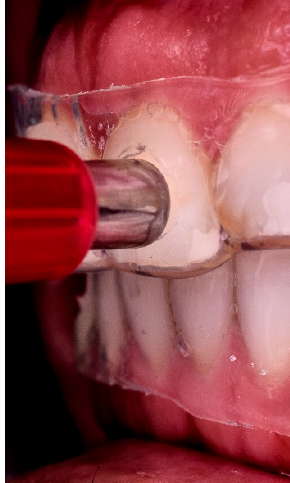
Figure 4. Color taking with spectrophotometer and positioning splints.